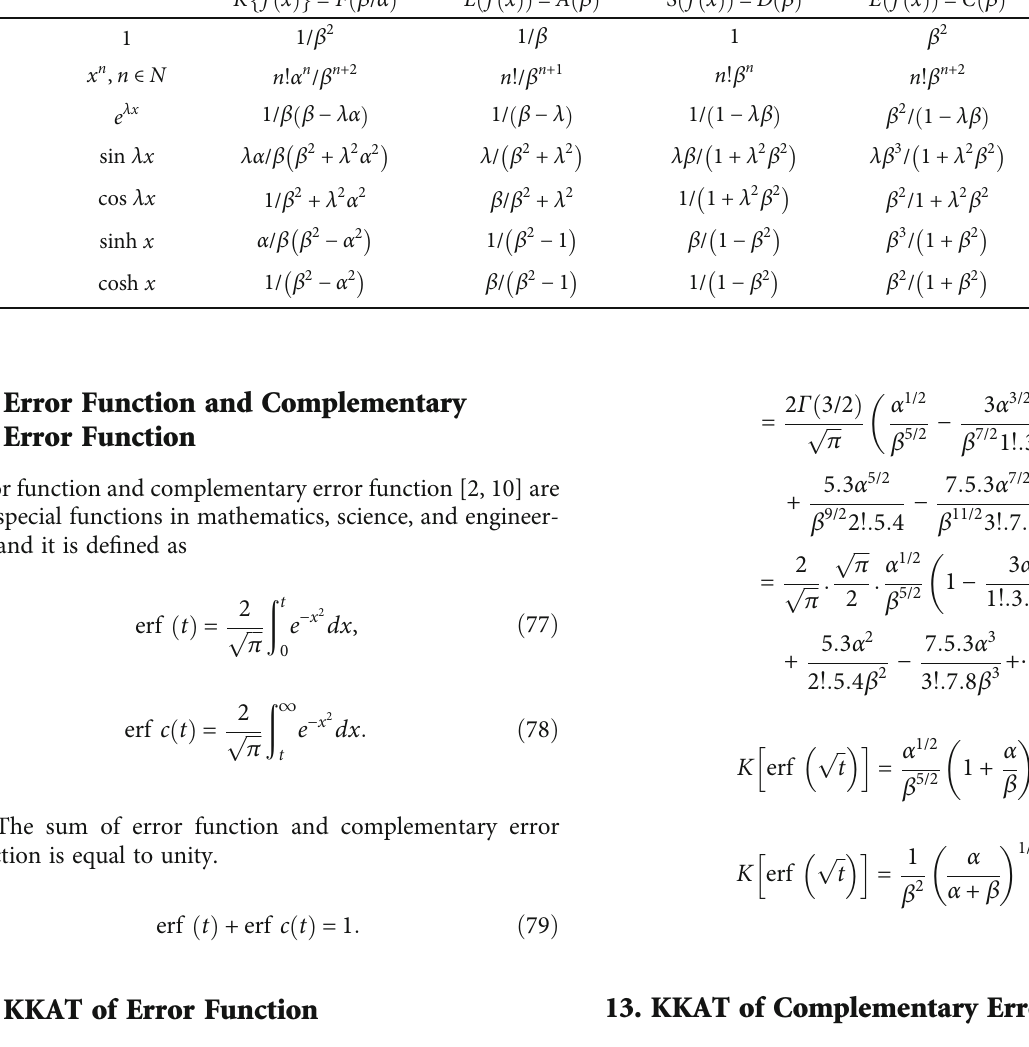
Table 4: Some important functions with KKAT, Laplace, Sumudu, Elzaki, and Rohit Transformations. Sr.